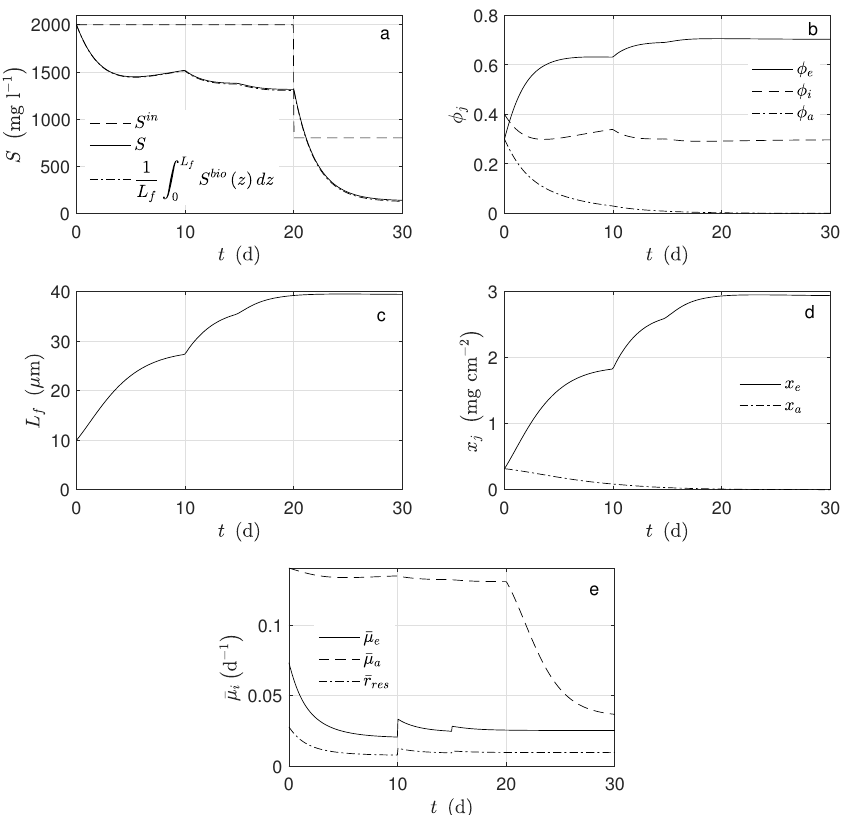
Figure 3. Numerical solution for the MEC model during chronoamperometry operation. ( a ) Substrate concentration, ( b ) mass fractions of microorganisms, ( c ) biofilm thickness, ( d ) microorganisms concentration, and ( e ) average reaction